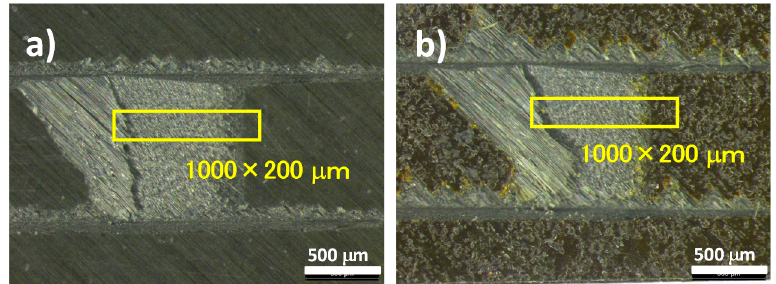
Figure 5. Measuring positions of ( a ) CFRP and ( b ) degraded CFRP samples (160 °C in 14 days with moisture) for electron probe micro-analysis (EPMA).